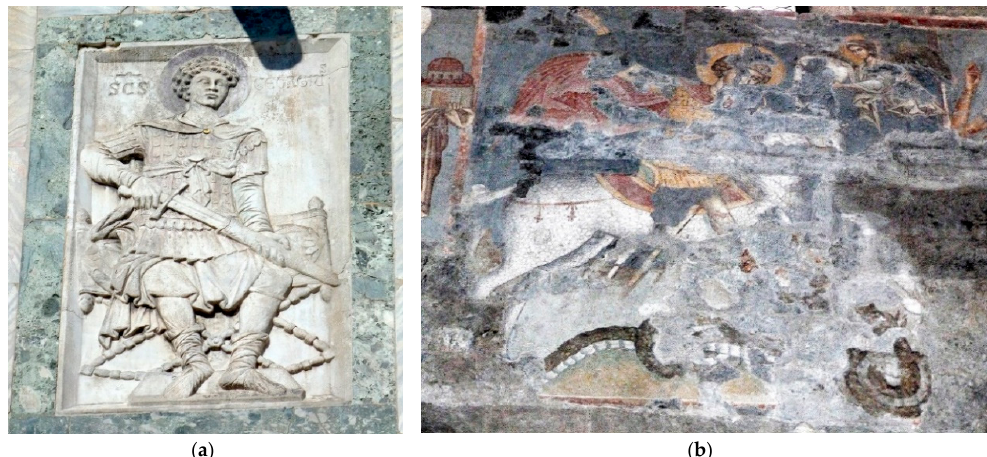
Figure 2. ( a ) St George. Façade of the basilica of Saint Mark in Venice, 13th century. © Author “per gentile concessione della Procuratoria di San Marco”. ( b ) Marcus (?), St George horsing and slaying the Dragon. Cathedral of Genoa, north aisle, ca. 1312. © Author.